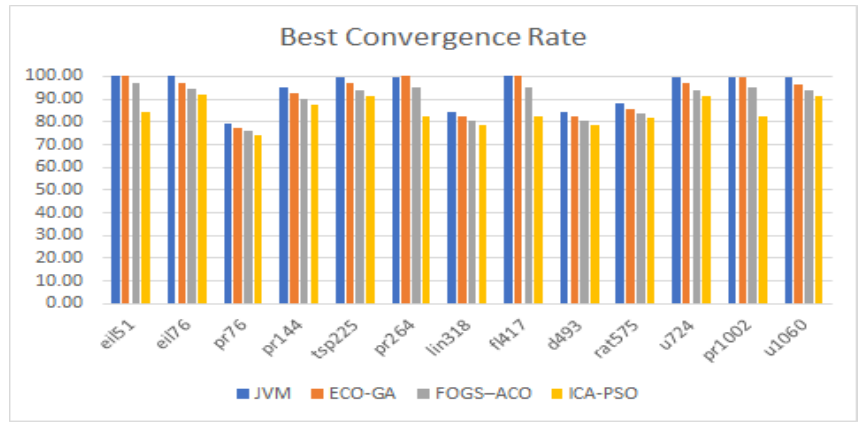
Figure 5. Best convergence rate.